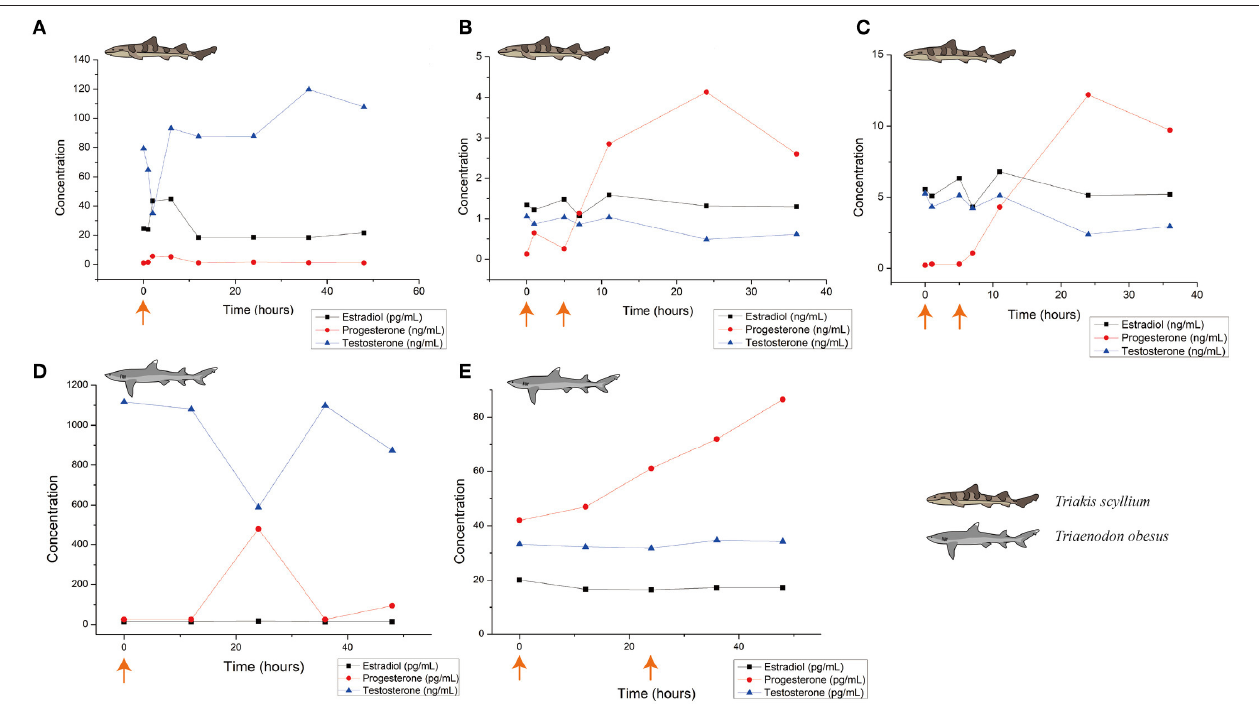
FIGURE 3 | Blood hormone level changes after Ovaprim ® injection in Triakis scyllium and Triaenodon obesus . (A) average hormone concentration changes in male T. scyllium . Ovaprim ® was injected at 0.2 mL/kg dose at the orange arrowed time point. (B) Average hormone concentration changes of female T. scyllium . Ovaprim ® was injected at 0.6 mL/kg dose at the orange arrowed time points. (C) Average hormone concentration changes of T. scyllium (Female #3; F003). Ovaprim ® was injected at 0.6 mL/kg dose at the orange arrowed time point. (D) Average hormone concentration changes of male T. obesus . Ovaprim ® was injected at 0.2 mL/kg dose at the orange arrowed time point. (E) Average hormone concentration changes in female T. obesus . Ovaprim ® was injected at 0.2 mL/kg and 0.3 mL/kg doses in serial at the orange arrowed time